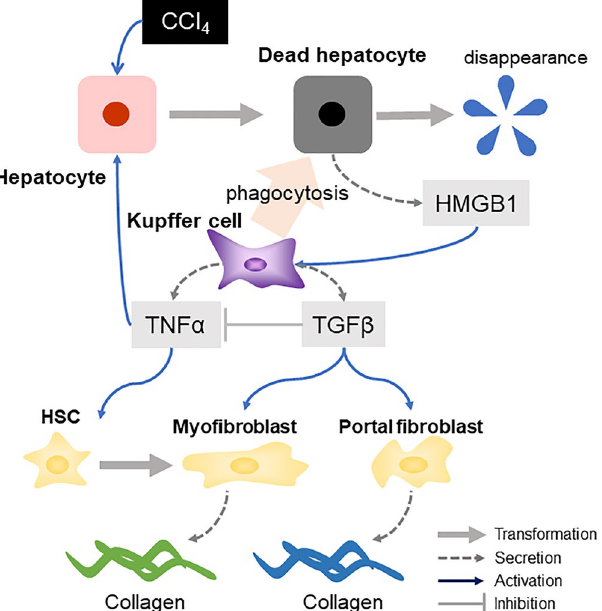
Figure 1. Concept of the developed model. (1) Hepatocytes exposed to toxic compounds (CCl 4 ) become dead cells. (2) Kupffer cells are activated by the phagocytosis of dead cells and secrete TNF-α and TGF-β. Insufficient clearance of dead cells causes accumulation of HMGB1, which also activates Kupffer cells. (3) HSCs are transformed into myofibroblasts when the concentration of TNF-α exceeds the pre-defined threshold. (4) Myofibroblasts and portal fibroblasts secrete collagens when the concentration of TGF-β exceeds the pre-defined threshold. Here, two types of collagens were implemented separately depending on their